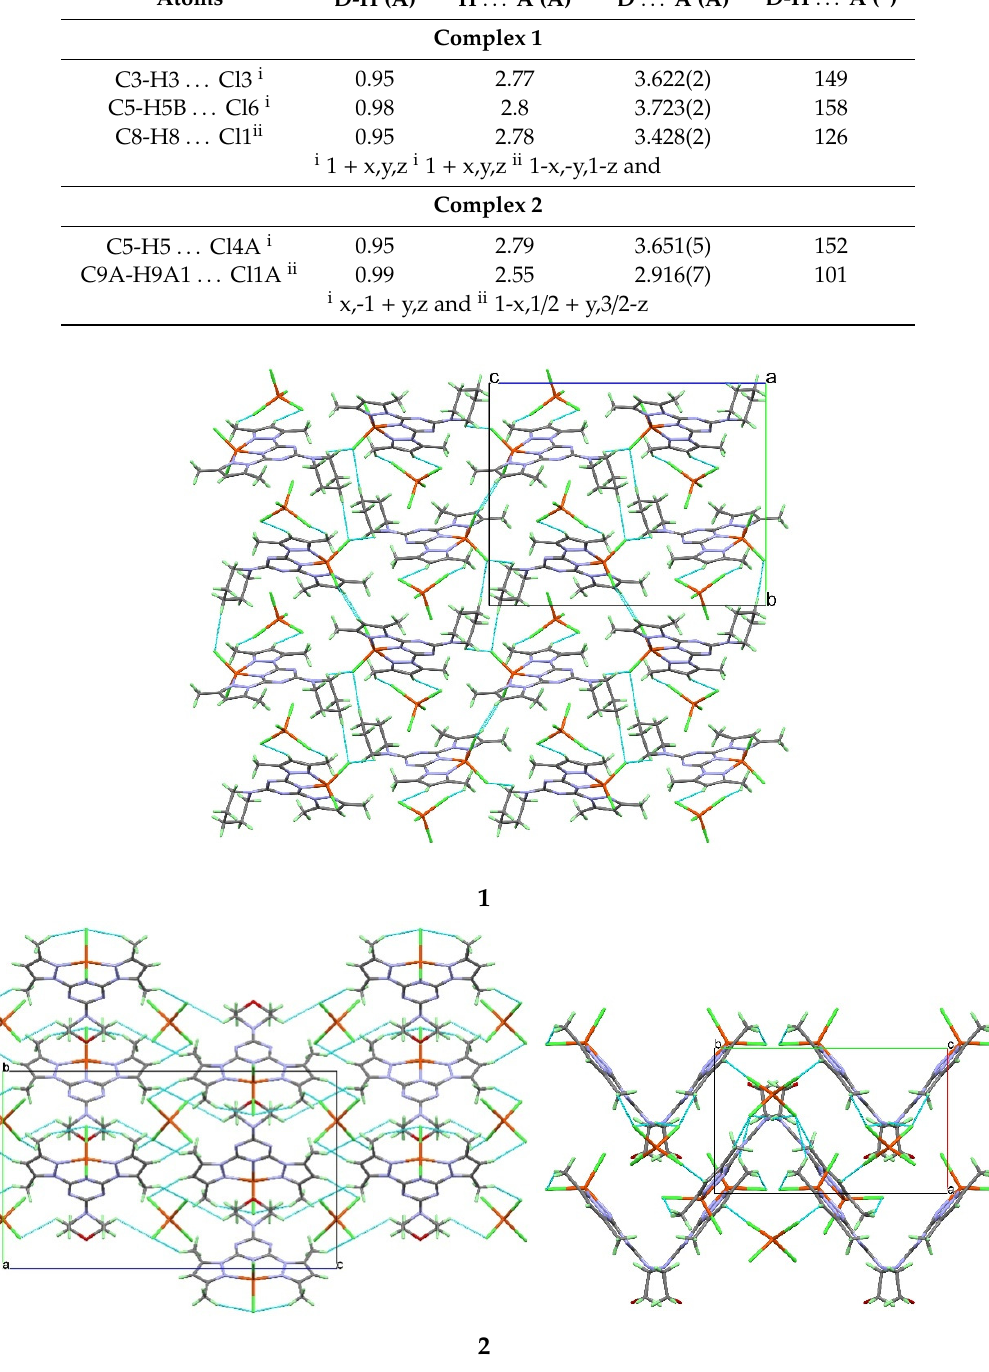
Figure 4. The hydrogen bond polymers in the crystal structures of complexes 1 (upper, view along the a -axis) and 2 (lower, views along the a - and c -axes). The hydrogen bridges are shown as light-blue dotted lines. Table 3. Hydrogen bond parameters of complexes 1 and 2 .